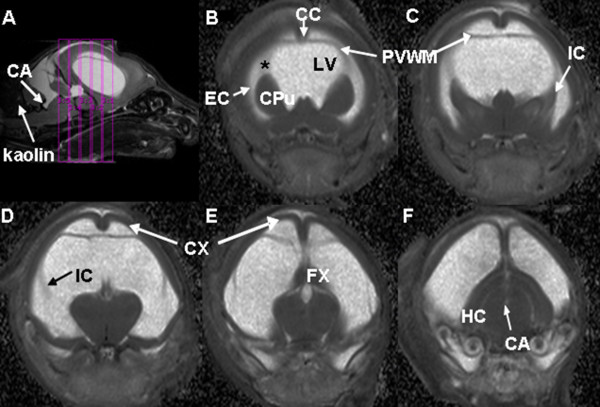
Mean diffusivity maps of hydrocephalic rats at postnatal day 11. The mid-sagittal image (A) shows the location of the five coronal slices (B-F) arranged from rostral to caudal. The expansion of the lateral ventricle and the posterior recess of the cerebral aqueduct (CA) can also be seen. Abbreviations: CC, corpus callosum; CPu, caudate-putamen; CX, cortex; EC, external capsule; FX, fornix; IC, internal capsule; HC, hippocampus; LV, lateral ventricle; PVWM, periventricular white matter.